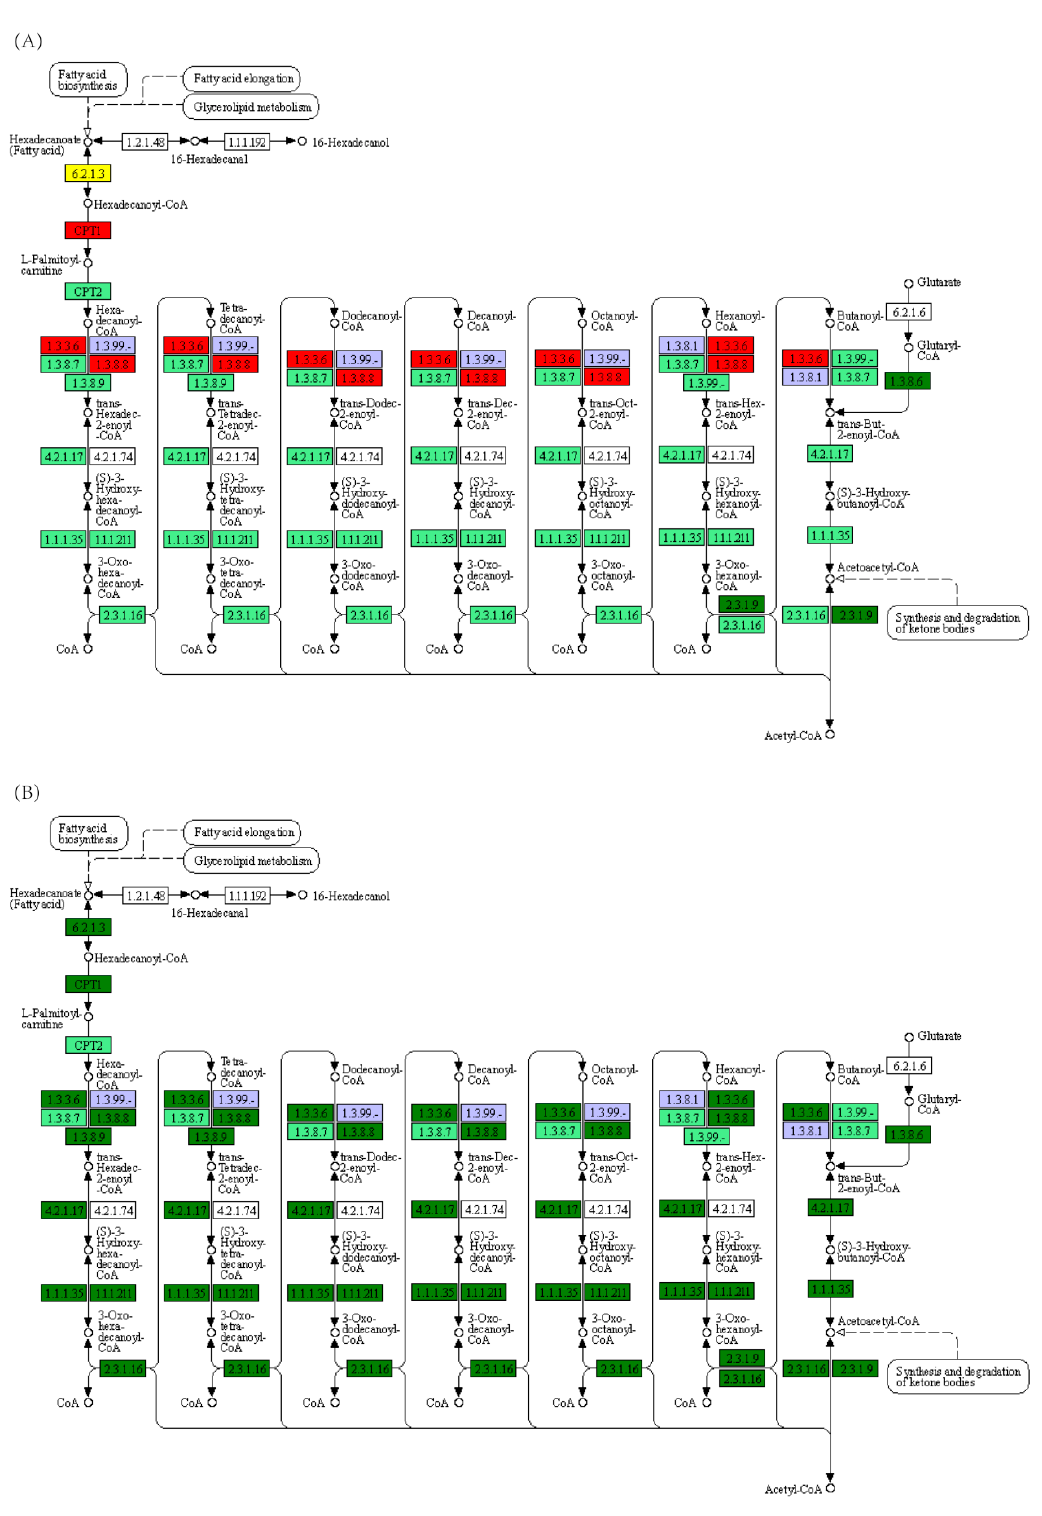
green, yellow, light green, and light purple indicate signi fi cantly downregulated genes, both up- regulated and downregulated genes in the corresponding genes, the genes of the species annotated on the map, and the genes that were not annotated on the map, respectively.